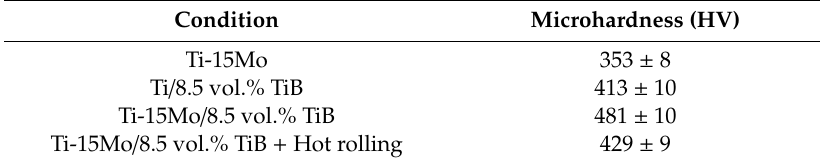
Table 1. Microhardness characteristics of samples with various compositions.